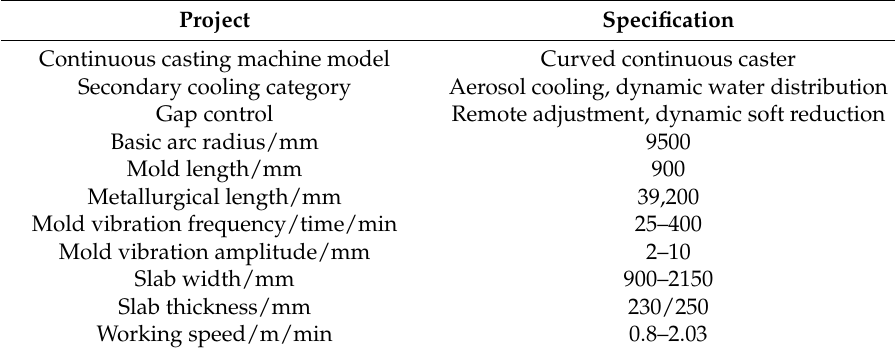
Table 2. Main technical parameters of the continuous casting machine.